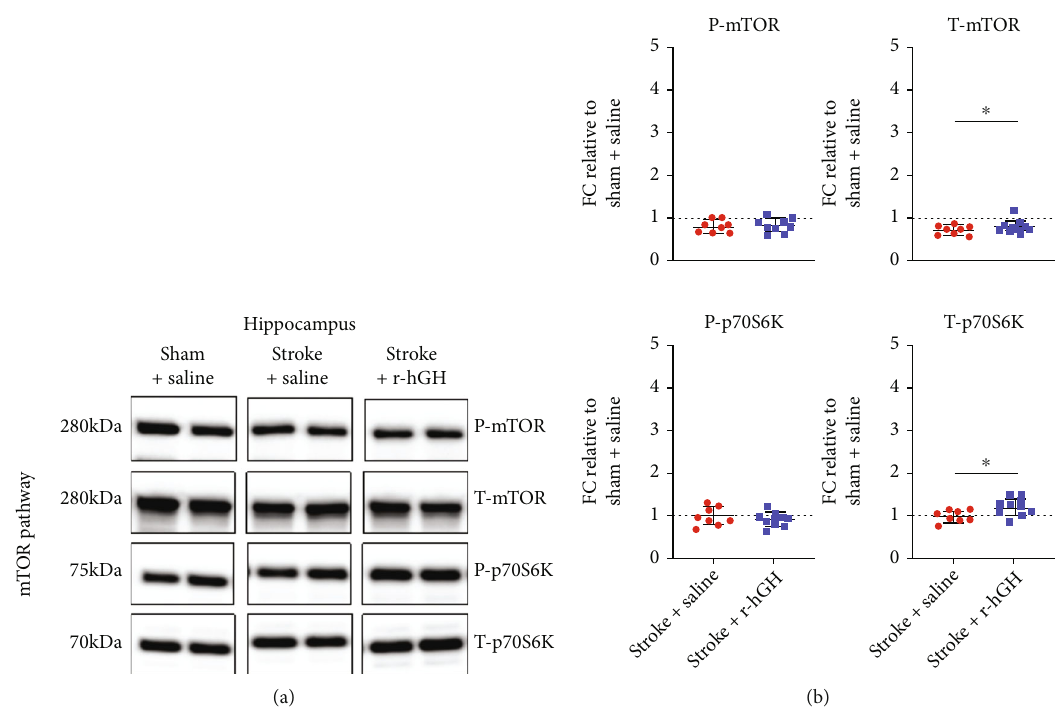
Figure 3: The e ff ect of recombinant human growth factor (r-hGH) treatment poststroke on mammalian target of rapamycin (mTOR) in the hippocampus. (a) Representative blots of phosphorylated-mTOR (P-mTOR, active form), total-mTOR (T-mTOR), phosphorylated-p70s6- kinase (P-p70S6K), and total-p70s6k (T-p70S6K). (b) Data are presented as in Figure 2. We found a signi fi cant increase in T-p70S6K protein expression within the hippocampus in stroked mice treated with r-hGH (blue squares) compared with saline (red circles). ∗ p < 0 : 05 , 2-tailed t